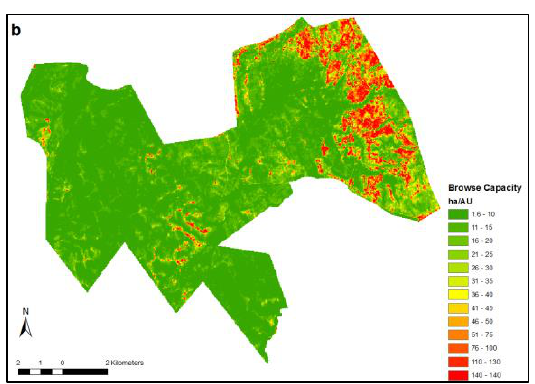
Figure 6. (b) Modelled browse